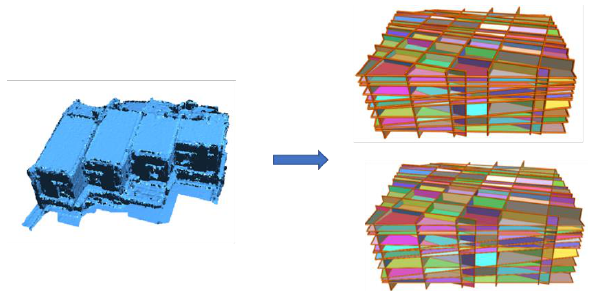
Figure 9. Refinement result and data set hypothesis